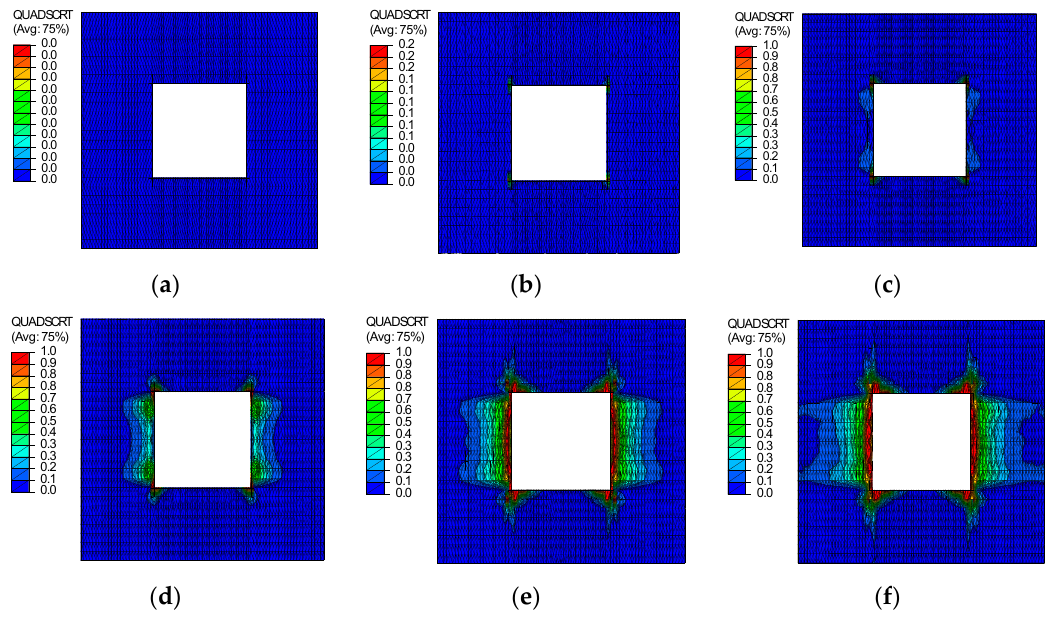
Figure 12. Evolution process of prefabricated delamination damage propagation region: ( a ) F = 0 kN; ( b ) F = 1.2 kN; ( c ) F = 12 kN; ( d ) F = 25.8 kN; ( e ) F = 45.7 kN; ( f ) F = 98 kN.